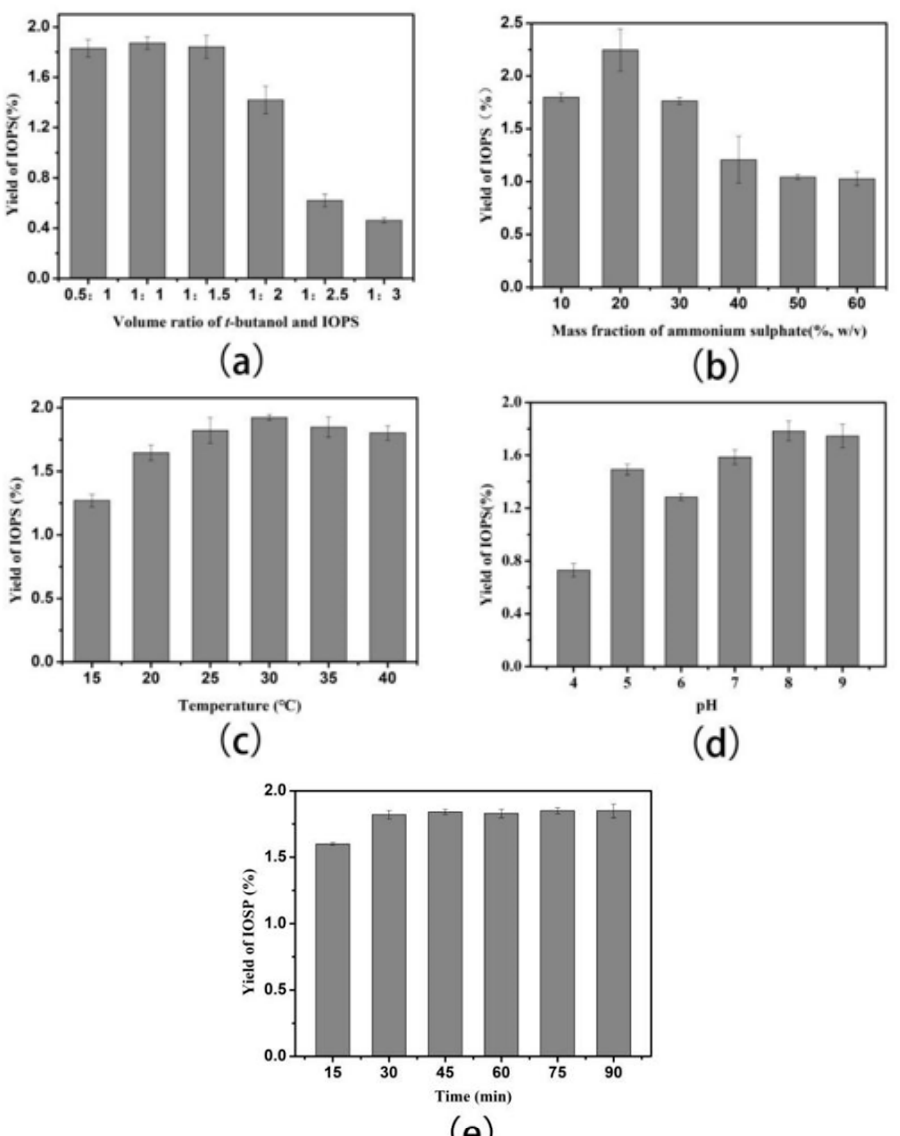
Figure 2. Effects of ( a ) amount of t -butanol (mL) on EY of IOPS using a solid-liquid ratio 1:12, a mass fraction of (NH 4 ) 2 SO 4 30% ( w / v ), a time of 30 min, and a temperature of 30 ◦ C at pH 8.0; ( b ) mass fraction of (NH 4 ) 2 SO 4 (%, w / v ) on the EY of IOPS using a solid-liquid ratio of 1:12, t -butanol (10 mL), an extraction time of 30 min, and a temperature of 30 ◦ C at pH 8.0; ( c ) temperature on the EY of IOPS using a solid-liquid ratio of 1:12, t -butanol (10 mL), a mass fraction of (NH 4 ) 2 SO 4 30% ( w / v ) , and an extraction time of 30 min at pH 8.0; ( d ) pH on the yield of IOPS using a solid-liquid ratio of 1:12, t -butanol (10 mL), a mass fraction of (NH 4 ) 2 SO 4 of 30% ( w / v ), an extraction time of 30 min, and a temperature of 30 ◦ C; ( e ) extraction time on the yield of IOPS using a solid-liquid ratio of 1:12, t -butanol (10 mL), a mass fraction of (NH 4 ) 2 SO 4 of 30% ( w / v ), and a temperature of 30 ◦ C at pH 8.0.